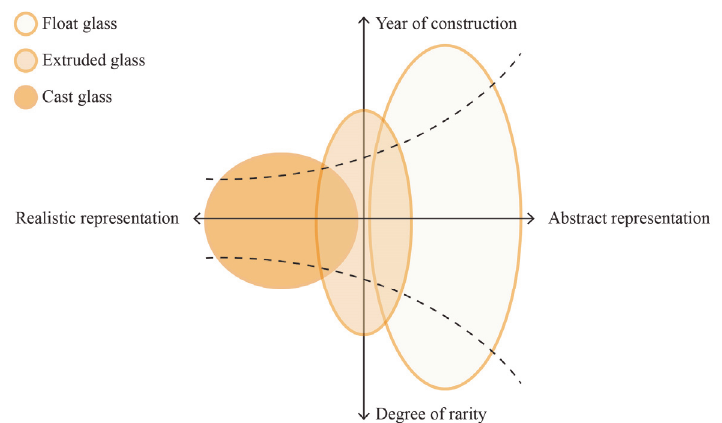
Fig. 12 Relation of age and rarity of a monument to the restoration concept of an abstract or realistic approach and the range of applicability for float, extruded and cast glass